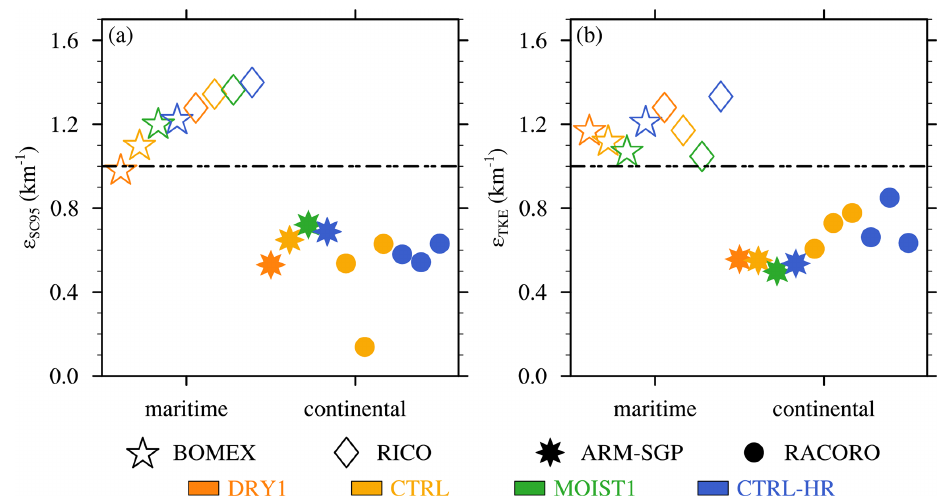
Figure 10. Fractional dilution rates for the 18 different cases (DRY1, CTRL, MOIST1, and CTRL-HR for BOMEX, RICO, and ARM-SGP and CTRL and CTRL-HR for RACORO – each of the three days counts as a separate case), for maritime cases (BOMEX and RICO), and continental cases (ARM-SGP and RACORO) calculated using (a) the SC95 diagnostic and (b) TKE estimate.